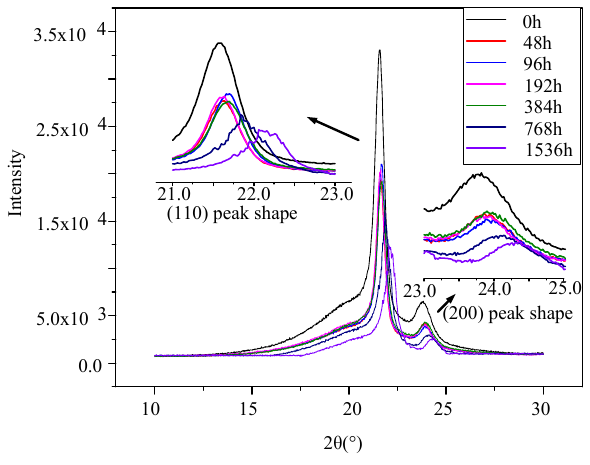
Figure 6. FTIR spectra of XLPE versus thermal aging time.